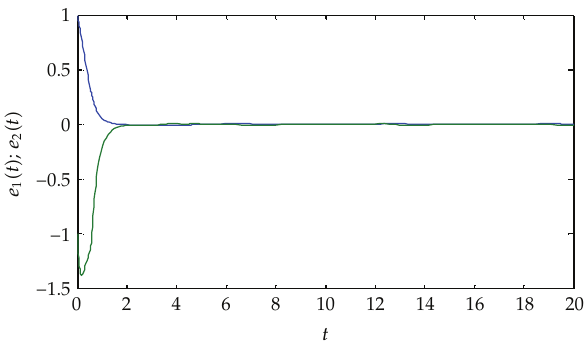
Figure 2: Synchronization errors of systems (cid:2) 3.1 (cid:3) – (cid:2) 3.7 (cid:3) with β (cid:9)